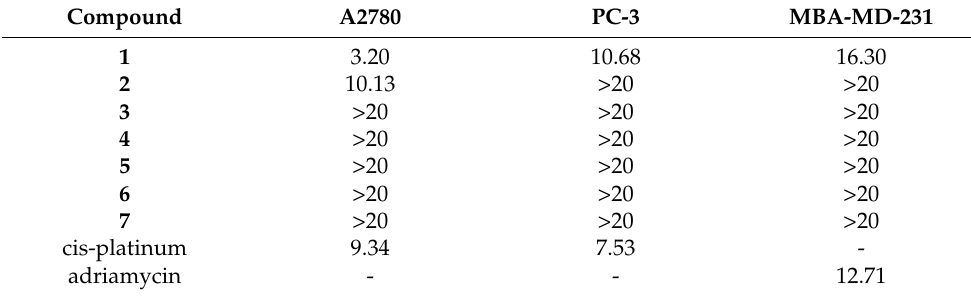
Table 6. Cytotoxicity of 1 – 7 against mammalian cell lines [half maximal inhibitory concentration (IC 50 ): µ